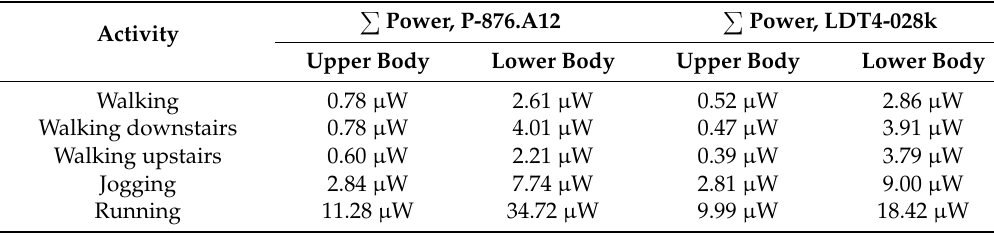
Table 9. Results shown in Table 8 divided by joint position: upper body and lower